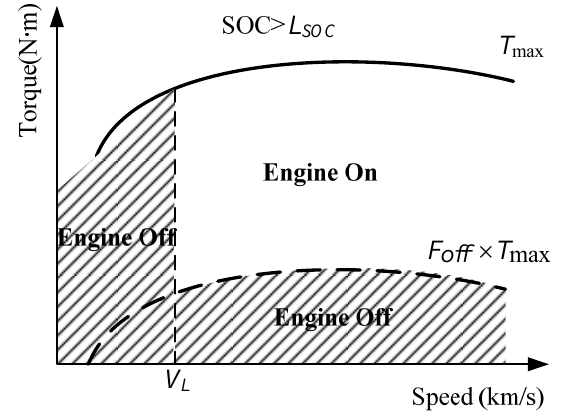
Figure 3. Electric assist control (